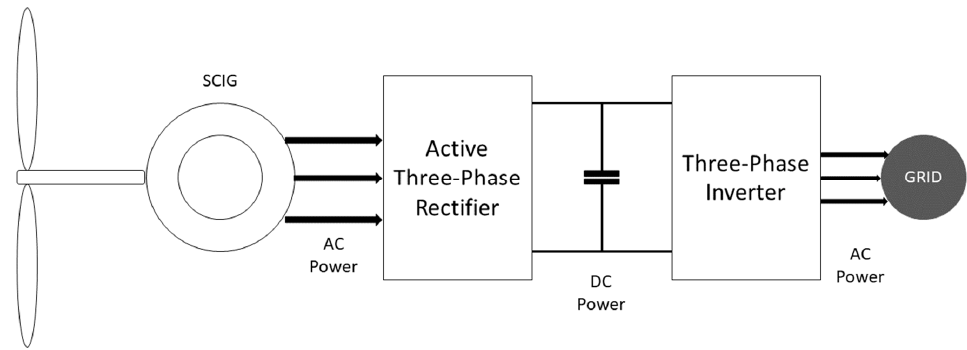
Figure 1. Typical Type 4 SCIG configuration.